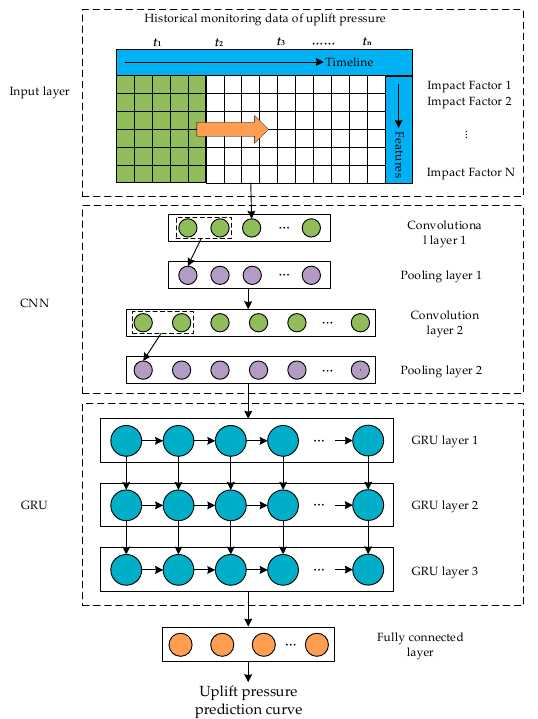
Figure 4. The structure of the CNN-GRU uplift prediction model. Table 1. CNN-GRU model parameter setting.